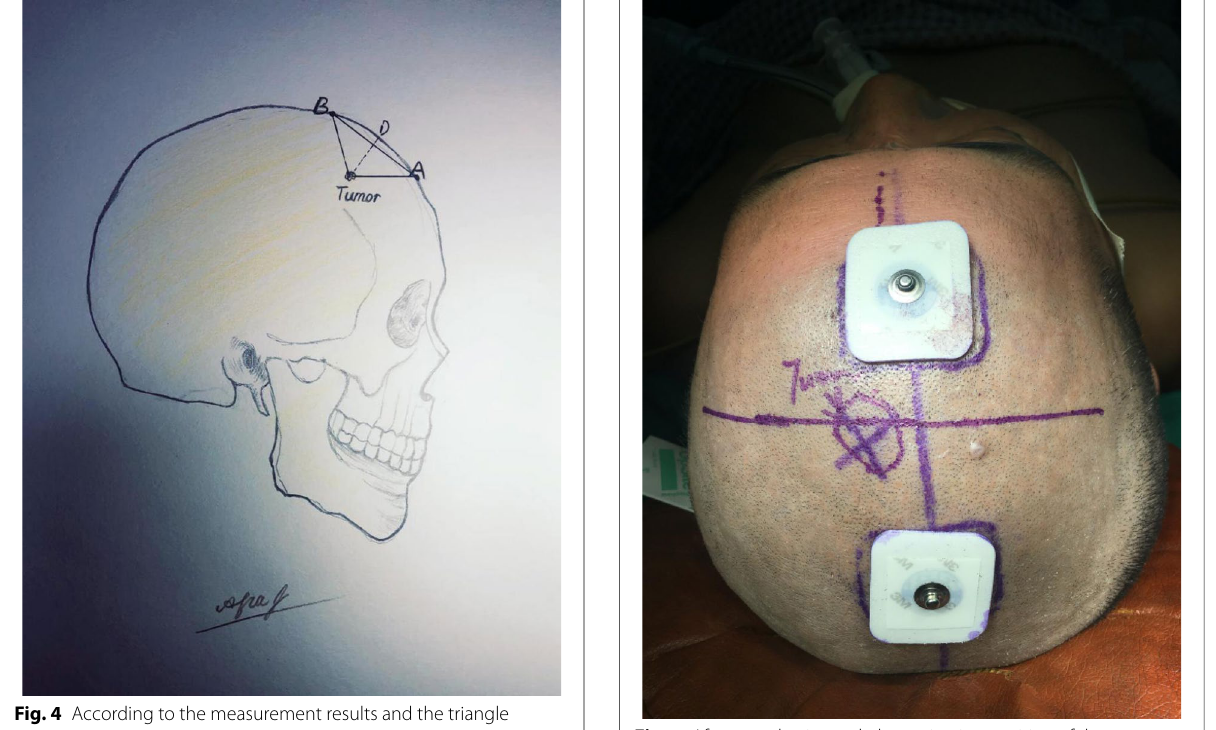
Fig. 5 After anesthesia, mark the projection position of the tumor on the scalp according to the calculation